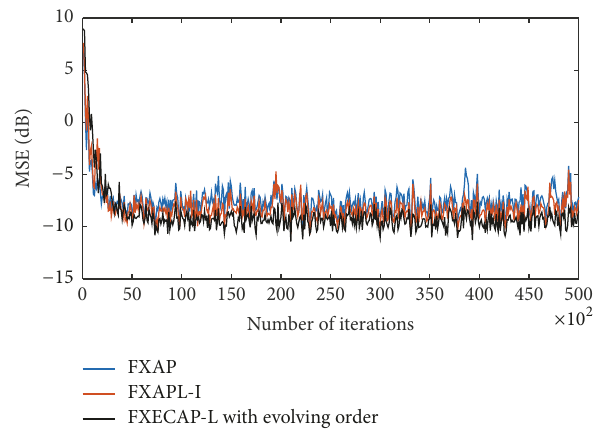
Figure 5: MSE values of the tested AP algorithms for a projection order of 𝐿 = 10 when 𝑏 = 2 bits are used to encode the error.